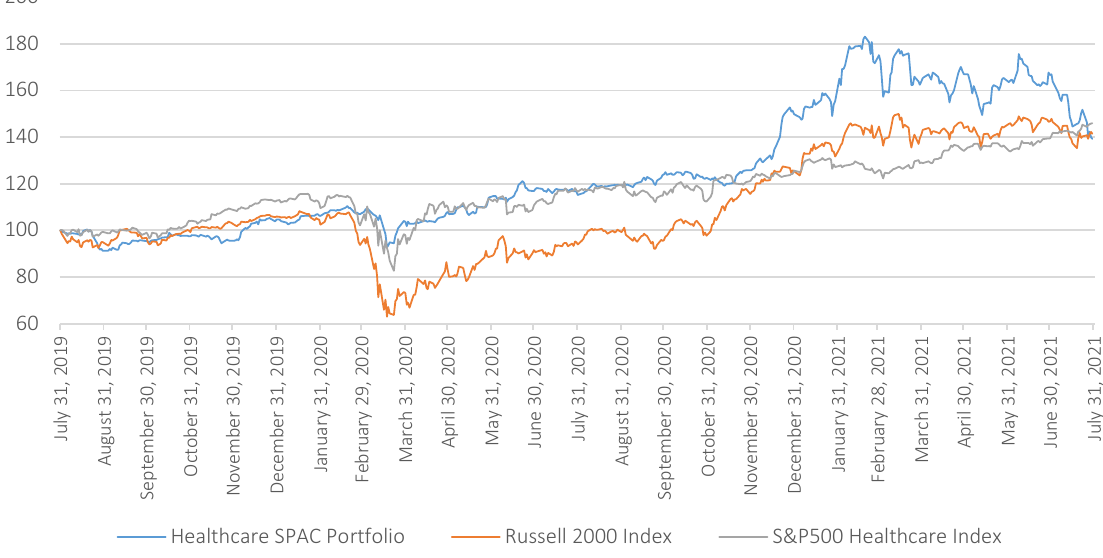
Figure 1. Healthcare SPAC portfolio performance versus